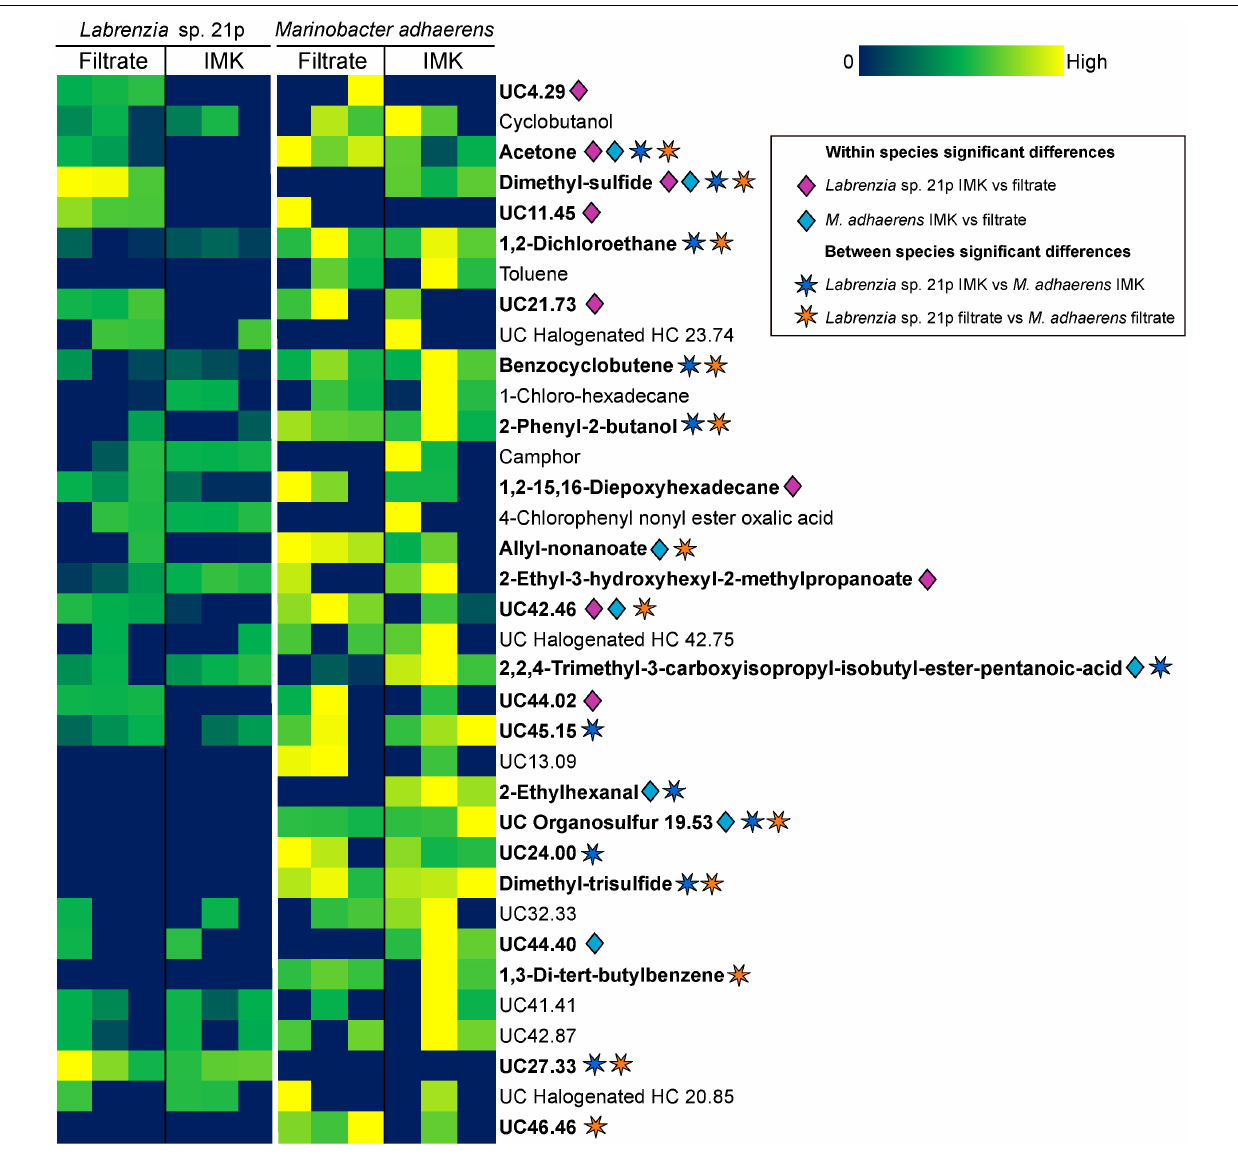
FIGURE 3 | Heat map of all BVOCs present in at least two out of three replicates of Labrenzia sp. 21p and Marinobacter adhaerens HP15 incubated in either IMK medium or algal filtrate. Color scale is specific to each compound. Significant differences ( p < 0.05; Kruskal–Wallis; IBM SPSS version 25) are denoted with diamonds for within species differences (pink for Labrenzia sp. 21p IMK vs. filtrate; blue for M. adhaerens IMK vs. filtrate) and stars for between species differences (dark blue for Labrenzia sp. 21p IMK vs. M. adhaerens IMK; orange for Labrenzia sp. 21p filtrate vs. M. adhaerens filtrate). HC, hydrocarbon; UC, unclassified (the number following UC indicates the retention time of the